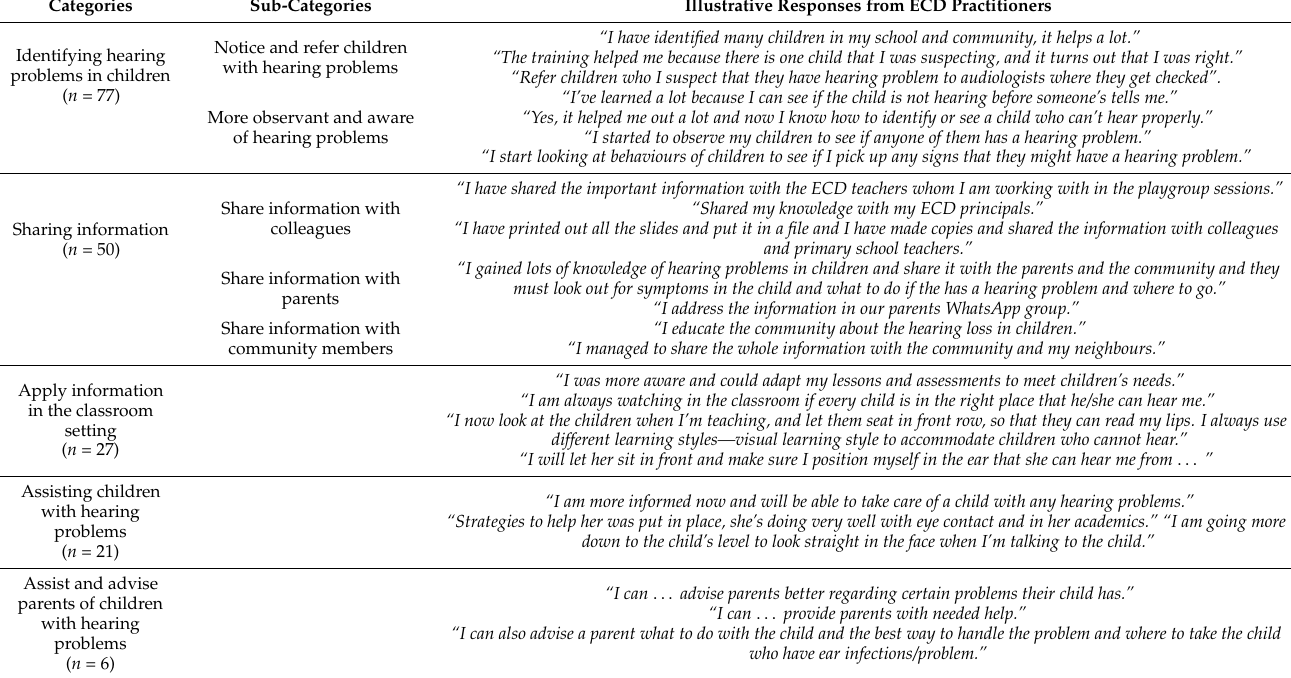
Table 5. Application of the EARS training information reported 6-month post training by ECD practitioners and analysed qualitatively ( n =